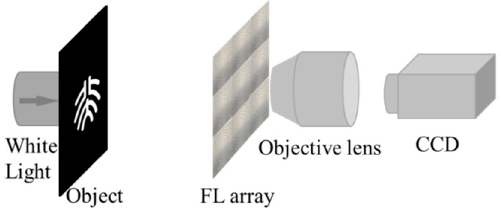
Figure 6. Schematic of the characterization system for the optical performance of the Fresnel lens array.